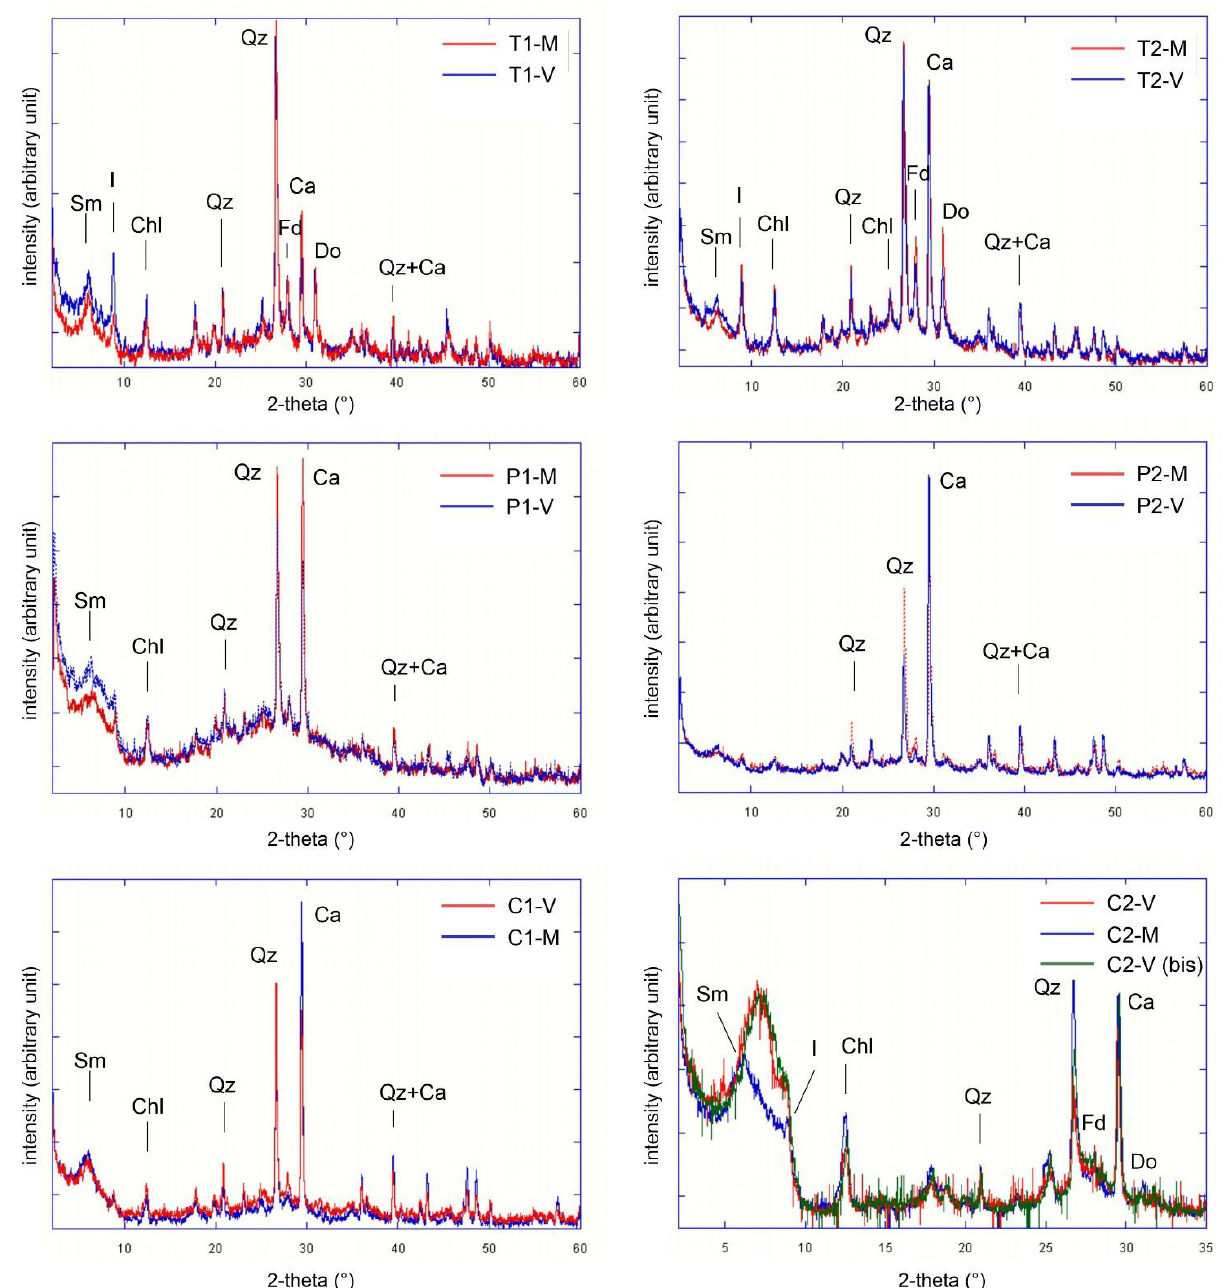
Figure 7. Results of the diffractometric analyses conducted in the 6 sample sites with highlighting of the main clay elements and minerals found: Sm = smectite, I = illite, Chl = chlorite, Qz = quartz, Ca = calcium, Fd = feldspar, Do = dolomite. The green line in site C2 refers to a second sample taken downstream of the water treatment plant of Tolentino.